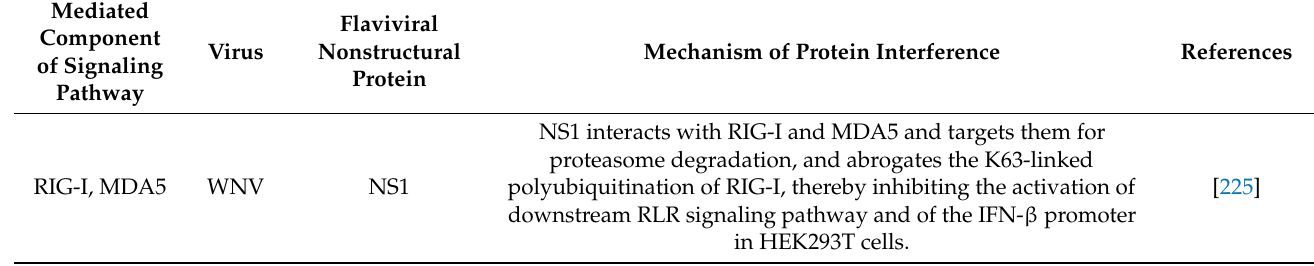
Table 2. Flaviviridae nonstructural proteins’ interference with RLR